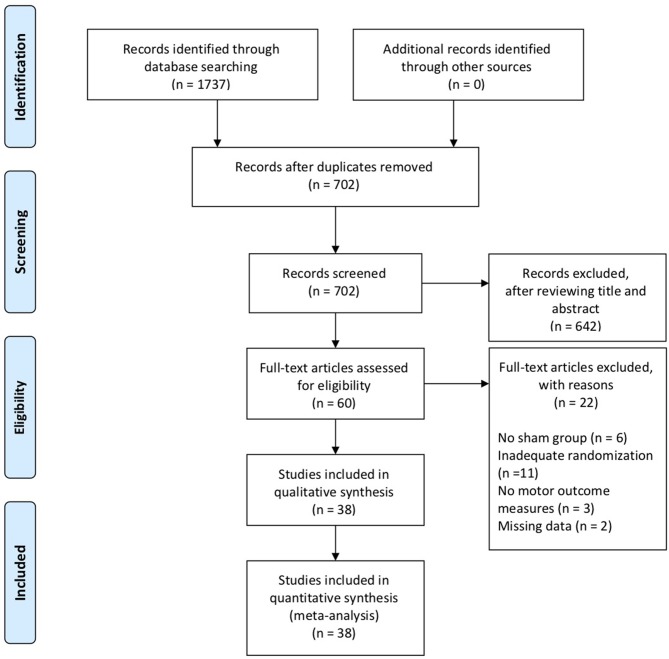
PRISMA flow chart.